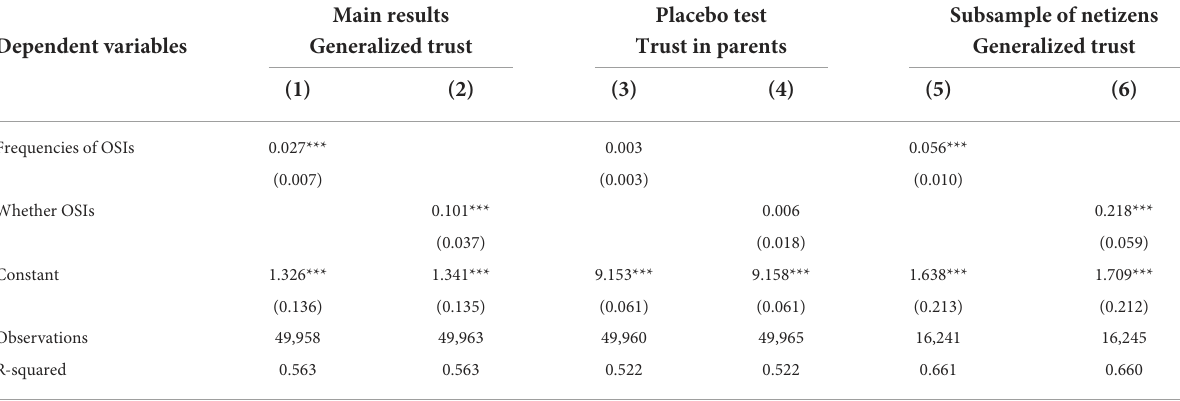
TABLE 2 Robustness checks with cross-sectional analyses.